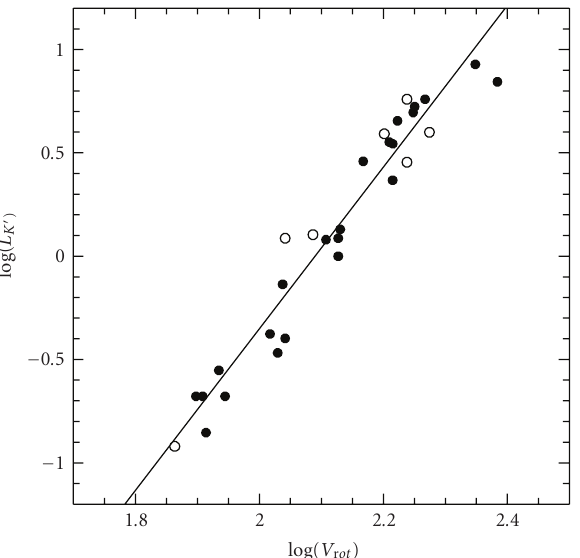
Figure 2: The near-infrared Tully-Fisher relation of Ursa Major spirals [5]. The rotation velocity is the asymptotically constant value. The line is a least-square fit to the data and has a slope of 3 . 9 ± 0 .